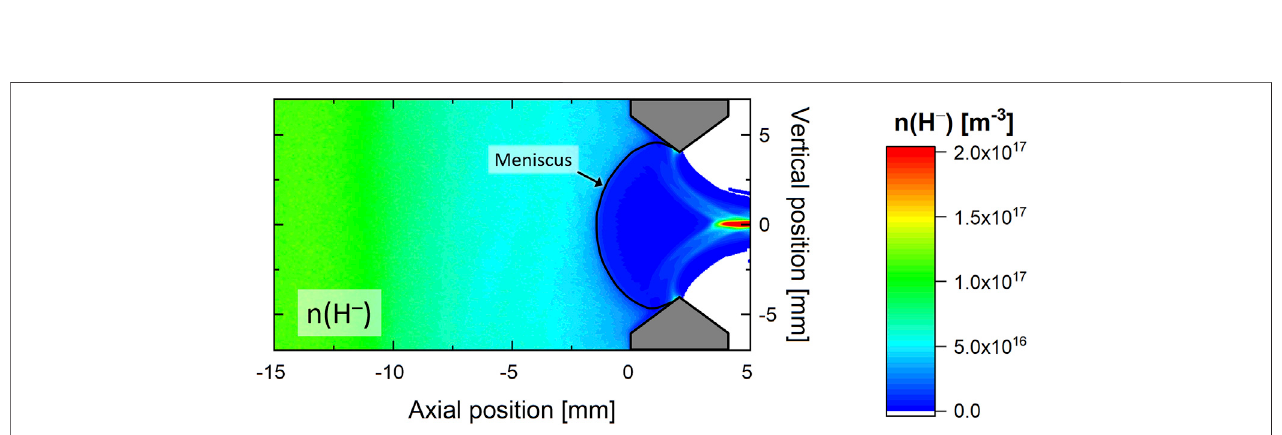
FIGURE 8 | Negative hydrogen ion density for a vertical cross-section through one extraction aperture of the former BATMAN test facility. Simulation result from ONIX [50]. Used input parameters: hydrogen, extraction voltage 10 kV, 0.6 eV temperature of surface-produced negative ions.